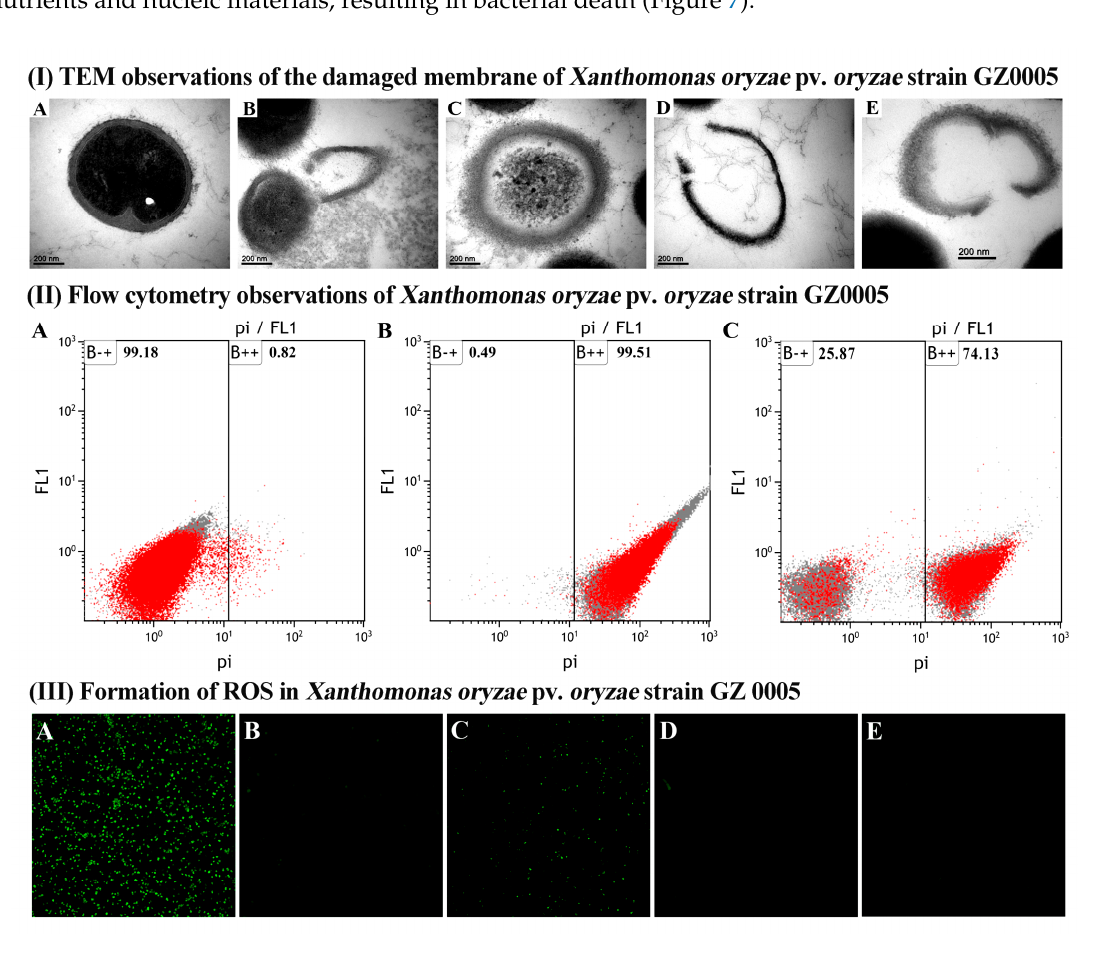
Figure 7. ( I ) TEM observations of the damaged membrane of Xanthomonas oryzae pv. oryzae strain GZ0005 treated with (A) sterile water, (B,C) CSNPs at 16 µ g / mL, and (D,E) ZnONPs at 16 µ g / mL. ( II ) Flow cytometry observations of Xanthomonas oryzae pv. oryzae strain GZ0005 cells after incubation with (A) sterile water, (B) CSNPs at 16 µ g / mL, and (C) ZnONPs at 16 µ g / mL. ( III ) Formation of ROS in Xanthomonas oryzae pv. oryzae strain GZ 0005 cells. (A) 4 h of incubation with CSNPs, (B) rotenone was added before 4 h of incubation with CSNPs, (C) 4 h of incubation with ZnONPs, (D) rotenone